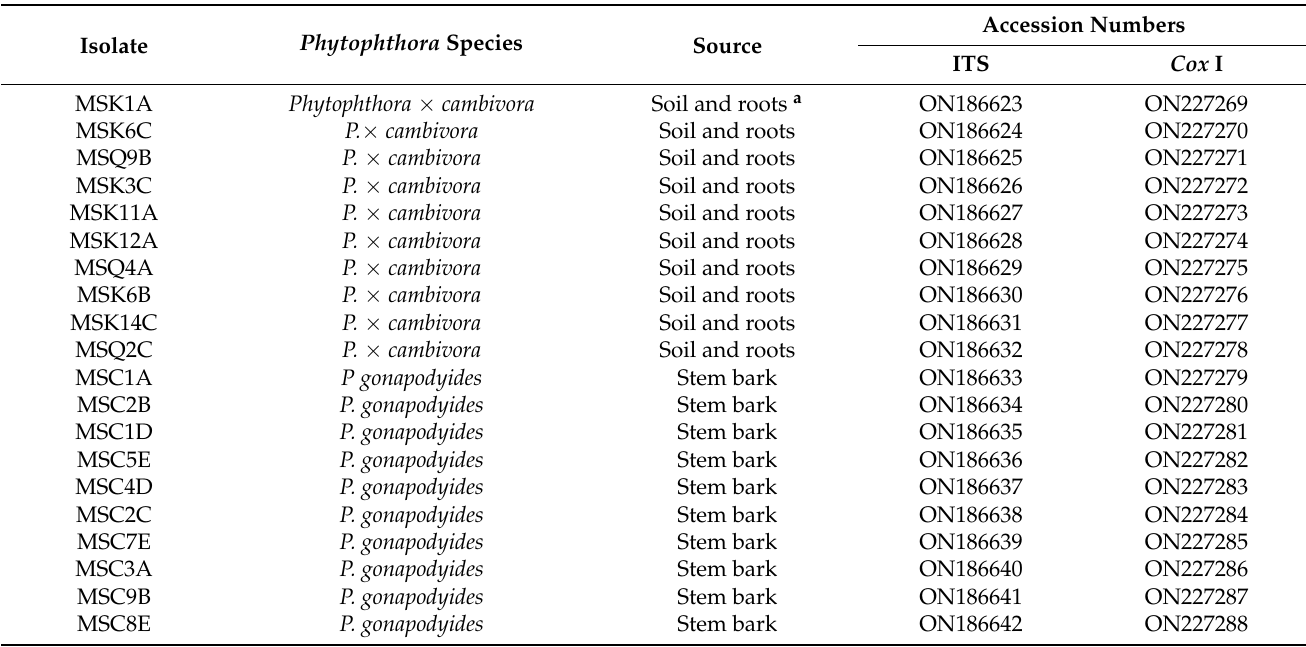
Table 1. Isolates of Phytophthora sourced from rhizosphere soil and different tissues (fine roots and stem bark) of European beech (Fagus sylvatica) trees in the Nebrodi Regional Park of Sicily, Italy, as characterized in this study.